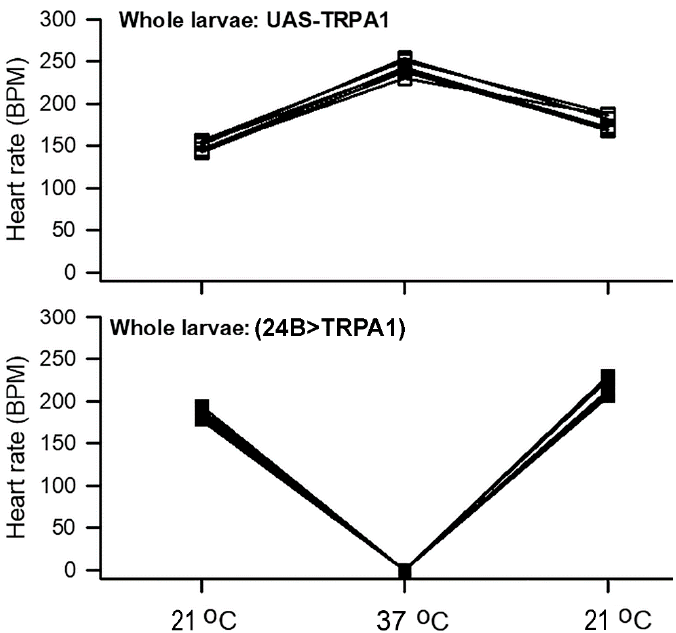
Figure 3. The heart rate for intact larvae. The heart rate increased in UAS TrpA1 and decreased for 24B>TrpA1 from 21 to 37 °C ( p < 0.05, paired t -test). Hearts of 24B>TrpA1 larvae rapidly stopped 24B>TrpA1 from 21 to 37 ◦ C ( p < 0.05, paired t -test). Hearts of 24B>TrpA1 larvae rapidly stopped beating at 37 °C ( p < 0.05, paired t -test). The rates increased upon exposure back to 21 °C. beating at 37 ◦ C ( p < 0.05, paired t -test). The rates increased upon exposure back to 21 ◦